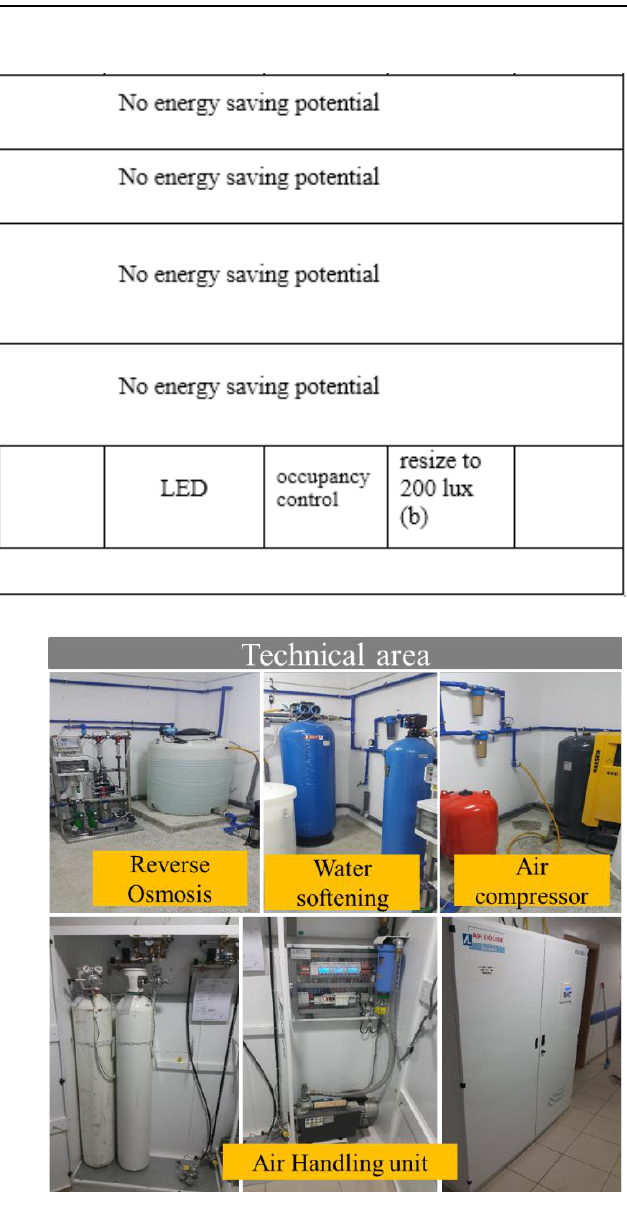
Figure 7 . Equipment and installation in technical zone in CSSD-UH of Oujda